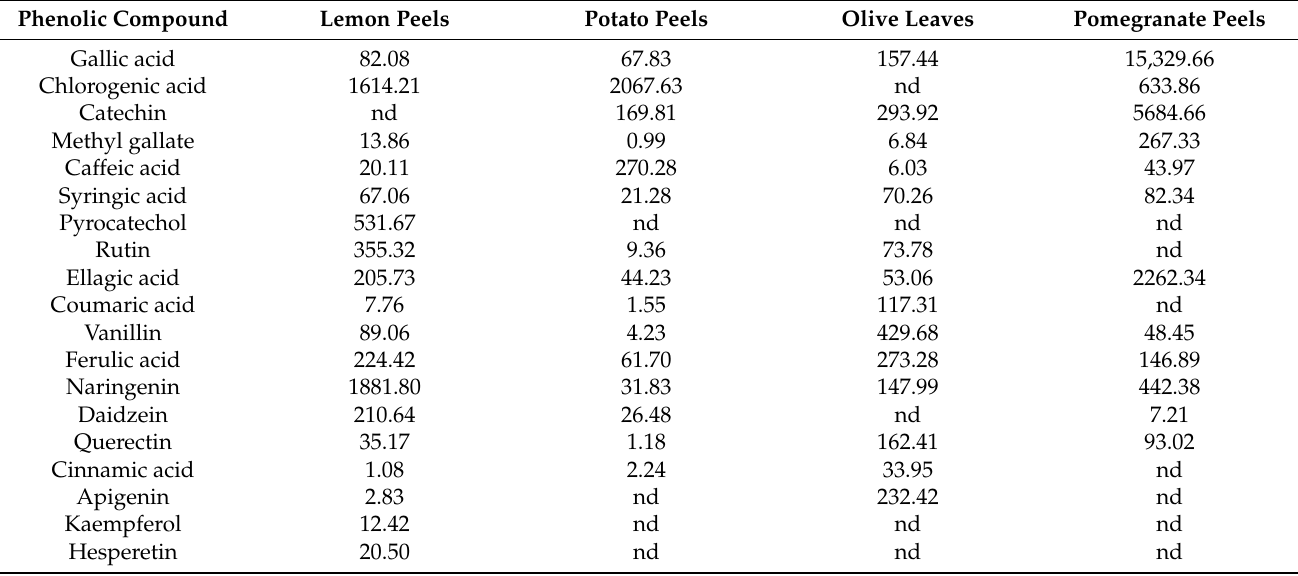
Table 2. HPLC analysis of phenolic compounds in various extracts samples ( µ